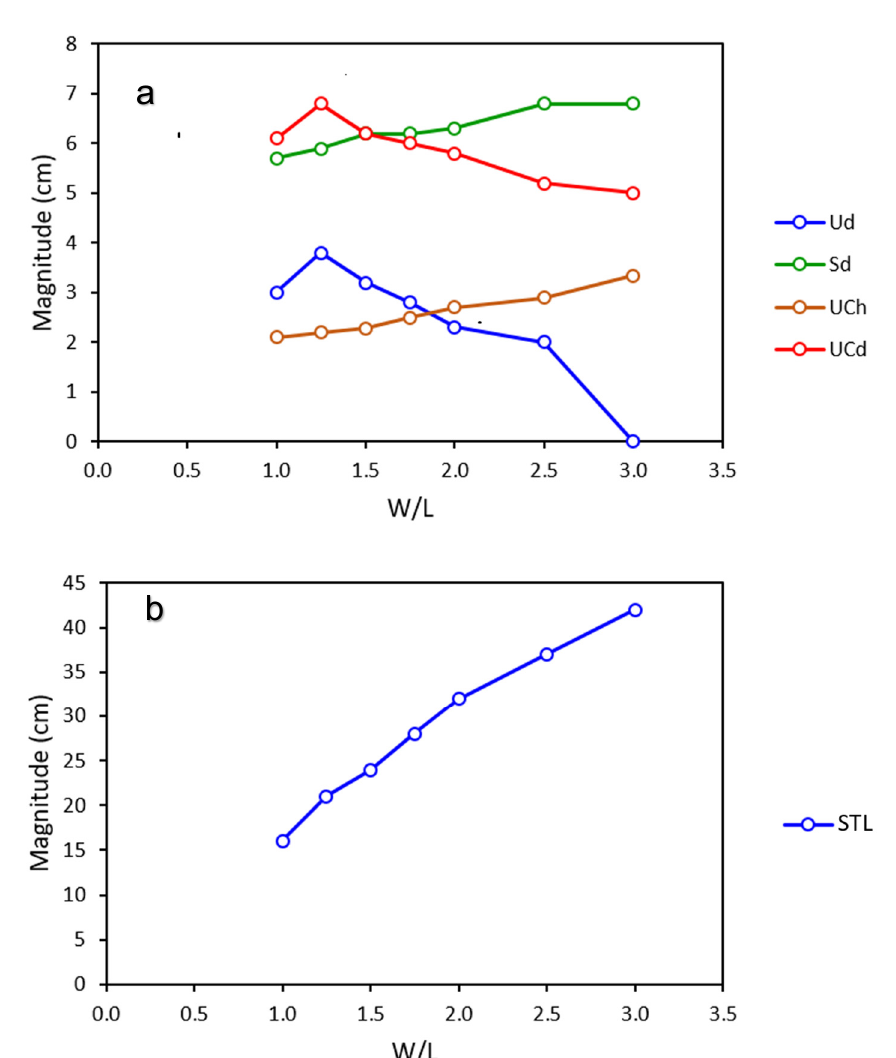
Figure 18. Effect of building width on sand accumulation around single-standing buildings. ( a ) Effect on Ud, Sd, Uch, and Ucd; ( b ) Effect on STL. (See Figure 16 for explanation of symbols).